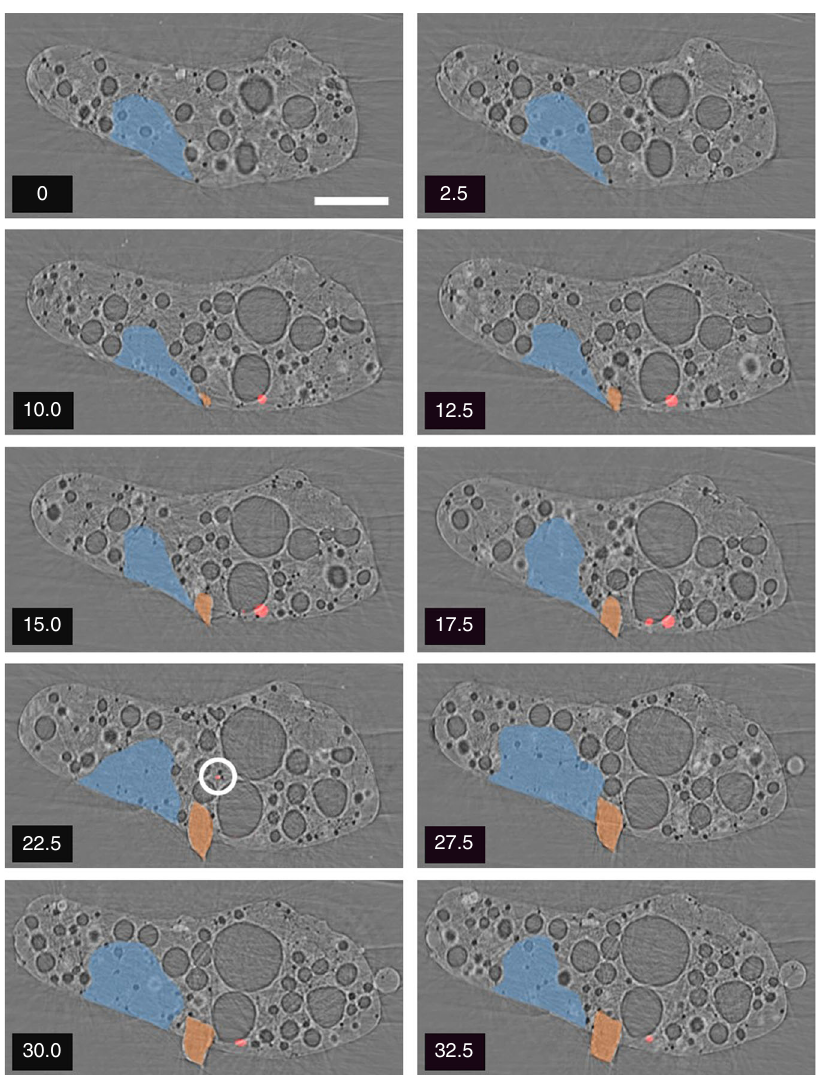
Fig. 1 Combined X-ray tomography and fl uorescence cross-sections: sequential longitudinal slices (upwards from the horizontal mid-plane) through the SR- μ -XRT reconstruction, overlain with U composition data (shown in red, and additionally circled in 22.5 µ m section) as determined via SR- μ -XRF mapping. The location of Fe (orange) and cement (blue) composition regions are highlighted. The values shown represent the thickness of the